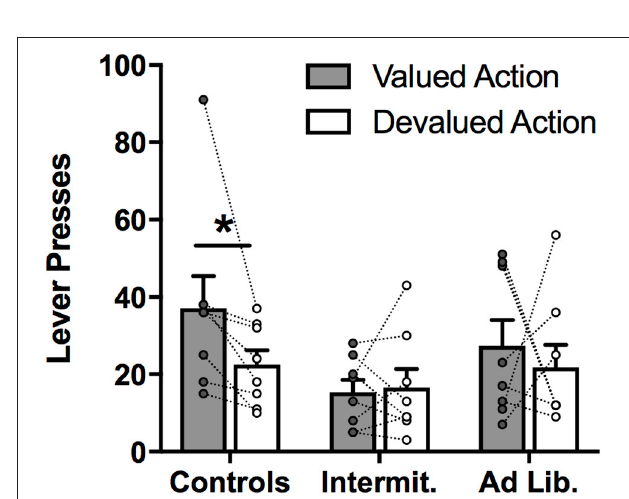
FIGURE 4 | Outcome devaluation test. Lever presses for the lever associated with either a valued or devalued outcome. Control rats pressed more on the valued versus devalued lever, while both junk food groups failed to show a preference for one action over the other. Means ± SEM, with individual points and repeated-measures lines. * p <